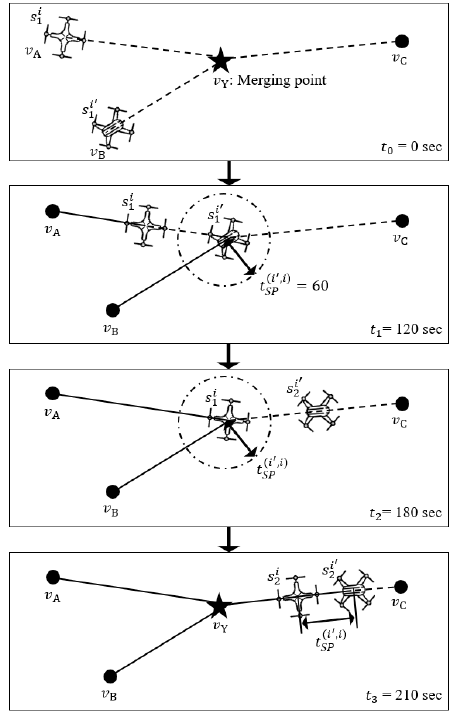
Figure 3. Time-based separation concept for merging points. α i and α i (cid:48) are represented by superscript i and i (cid:48) in the figure, fly from their origin v A and v B to v C through the merging point v Y at speeds { s i } and { s i (cid:48) } , respectively. The superscript and subscript of s are the sUAS index and segment , s i , s i (cid:48) 2 2 1 1 index,